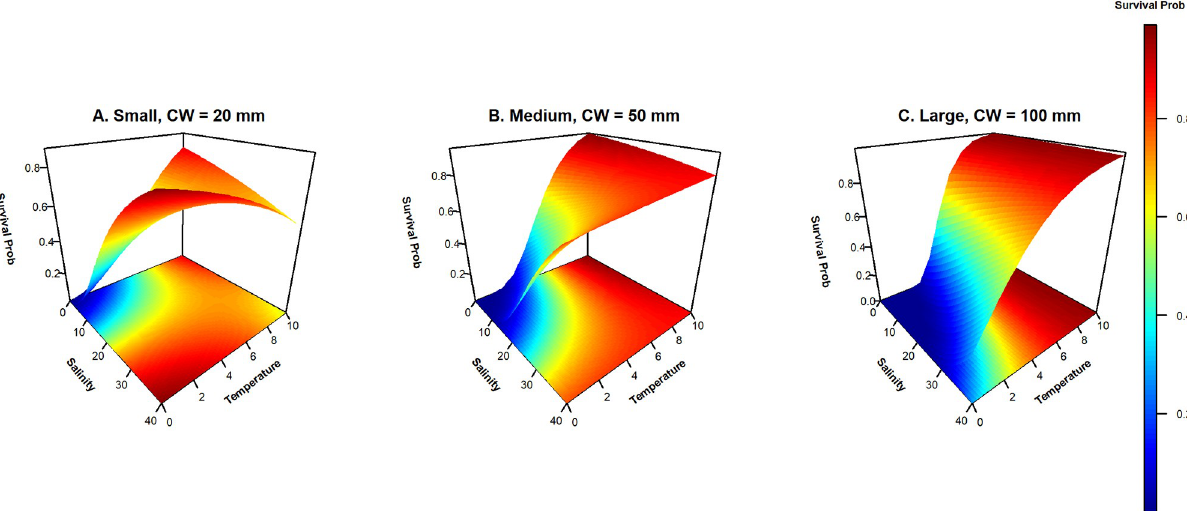
Fig 8. Survival estimates at 100 days of winter from the exponential model over a range of temperature and salinities that may be experienced in winter. The values for each point were calculated from the exponential model by inputting time, a representative carapace width for that size class, temperature, and salinity. Expected survival probability is shown on the z-axis and in the color of the contoured surface. Each panel shows the expected survival for an individual from one of the three size classes (A) Small: CW = 20 mm, (B) Medium: CW = 50 mm, (C) Large: CW = 100 mm.